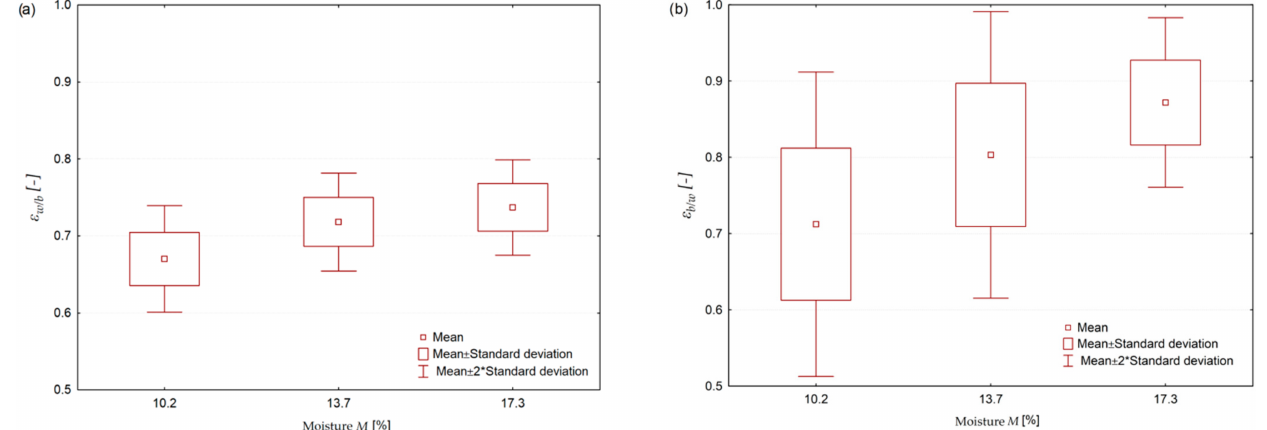
Figure 4. Mean values of separation efficiency ε , subject to the moisture M content of mixture components: ( a )—mixture of wheat kernels and buckwheat nutlets ( ε w/b ); ( b )—mixture of buckwheat nutlets and wheat kernels ( ε b/w